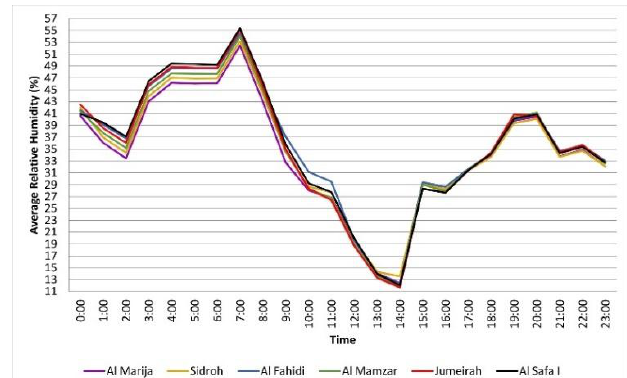
Figure 10. Hourly variations of relative humidity (%) for Al Marija, Sidroh, Al Fahidi, Al Mamzar, Jumeirah, and Al Safa I in August. Jumeirah, and Al Safa I in